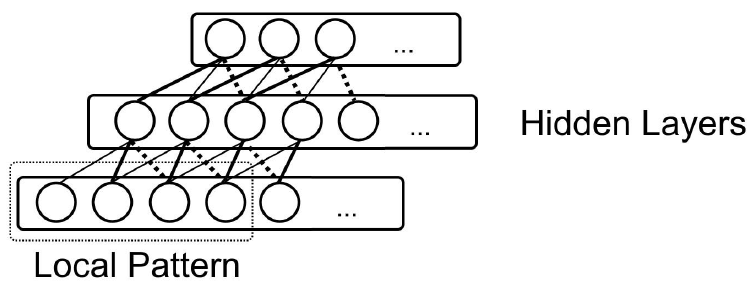
Figure 4. Architecture of the Convolutional Neural